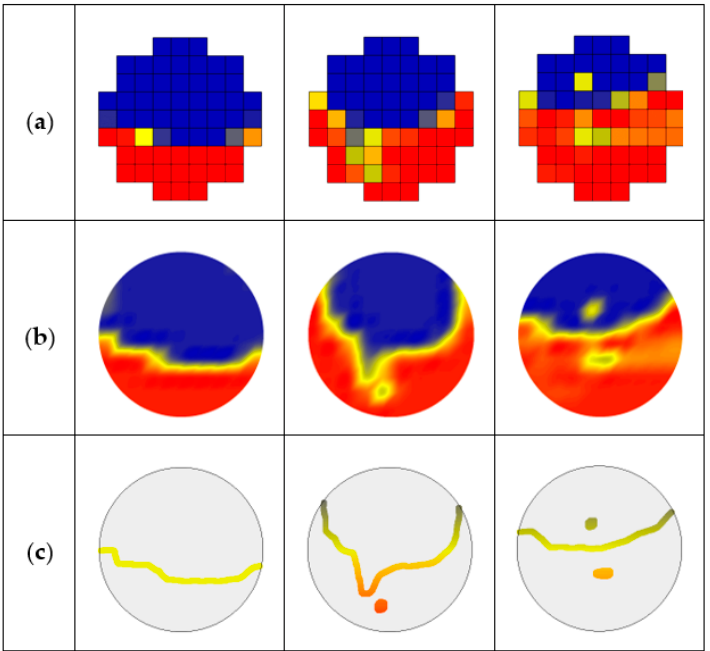
Figure 13. Extraction process of oil–water stratified interface and droplets: ( a ) Original normalized matrix V N ( k ); ( b ) Interpolation matrix V ip ( k ); ( c ) Extraction result of oil–water interface and droplets.